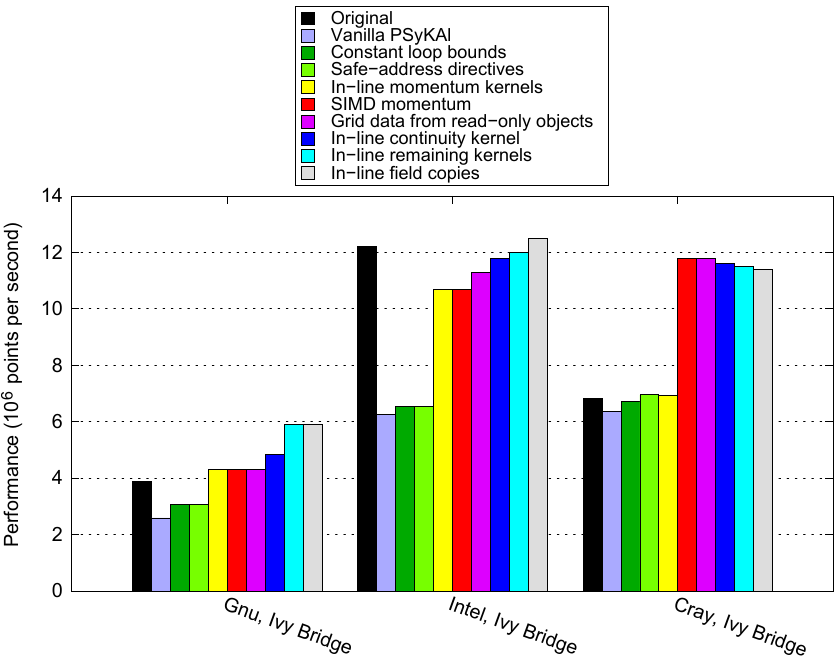
Figure 5. Serial performance of the PSyKAl version of NEMOLite2D for the 256 2 domain at each stage of optimization. The first (black) bar of each cluster gives the performance of the original version of NEMOLite2D for that compiler/CPU